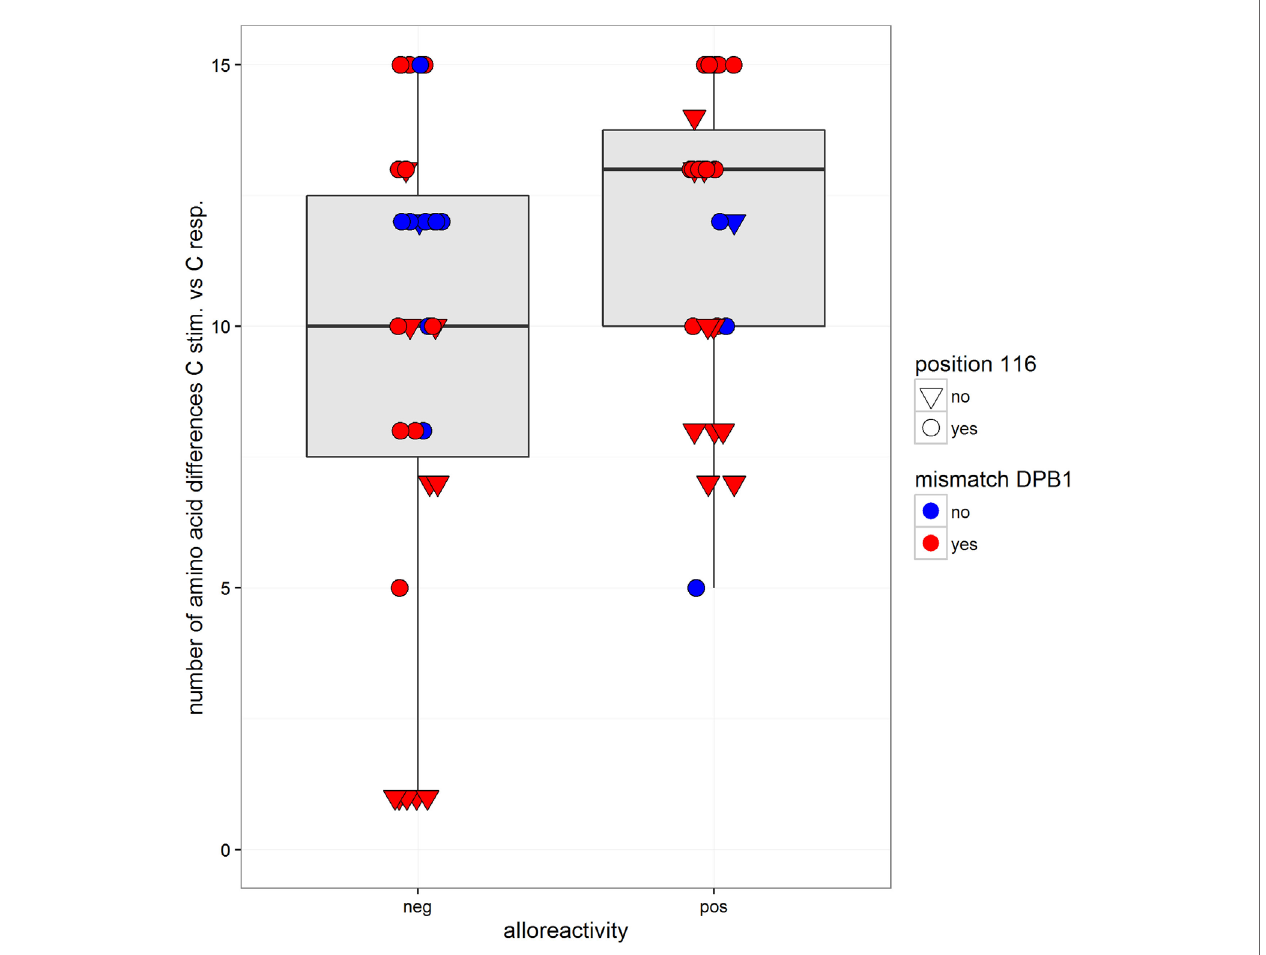
FigUre 4 | Box and whisker plots of the number of mismatched residues at hla-c between the stimulator and the responder alleles and alloreactivity defined as negative or positive (cutoff = 2% Δ cD137 + cD8 + cells) . The boxes correspond to the interquartile range, the median is the thick line inside the box, and whiskers extend up to observations that are outside the box for less than 1.5 times the interquartile range. No outliers to these limits were observed. The observations are also plotted individually with information on two predictor variables: matching at HLA-DPB1 is indicated by two different colors (blue for matched and red for mismatched HLA-DPB1), while variation at position 116 is indicated by the shape of the dots (a reversed triangle for matched and a circle for mismatched).